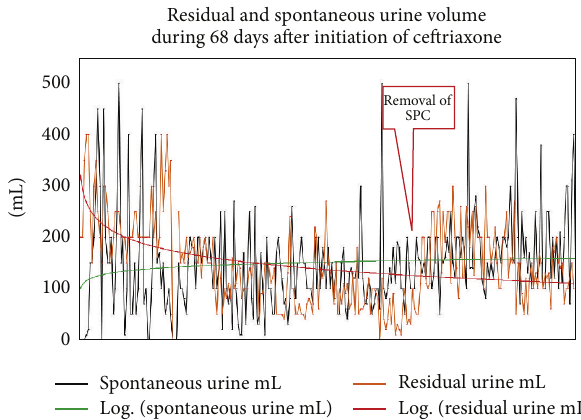
Figure 1: Course of residual urine volume and spontaneous urine volume after initiation of ceftriaxone during three weeks and during6weeksafterdiscontinuationofceftriaxone;SPC:suprapubic